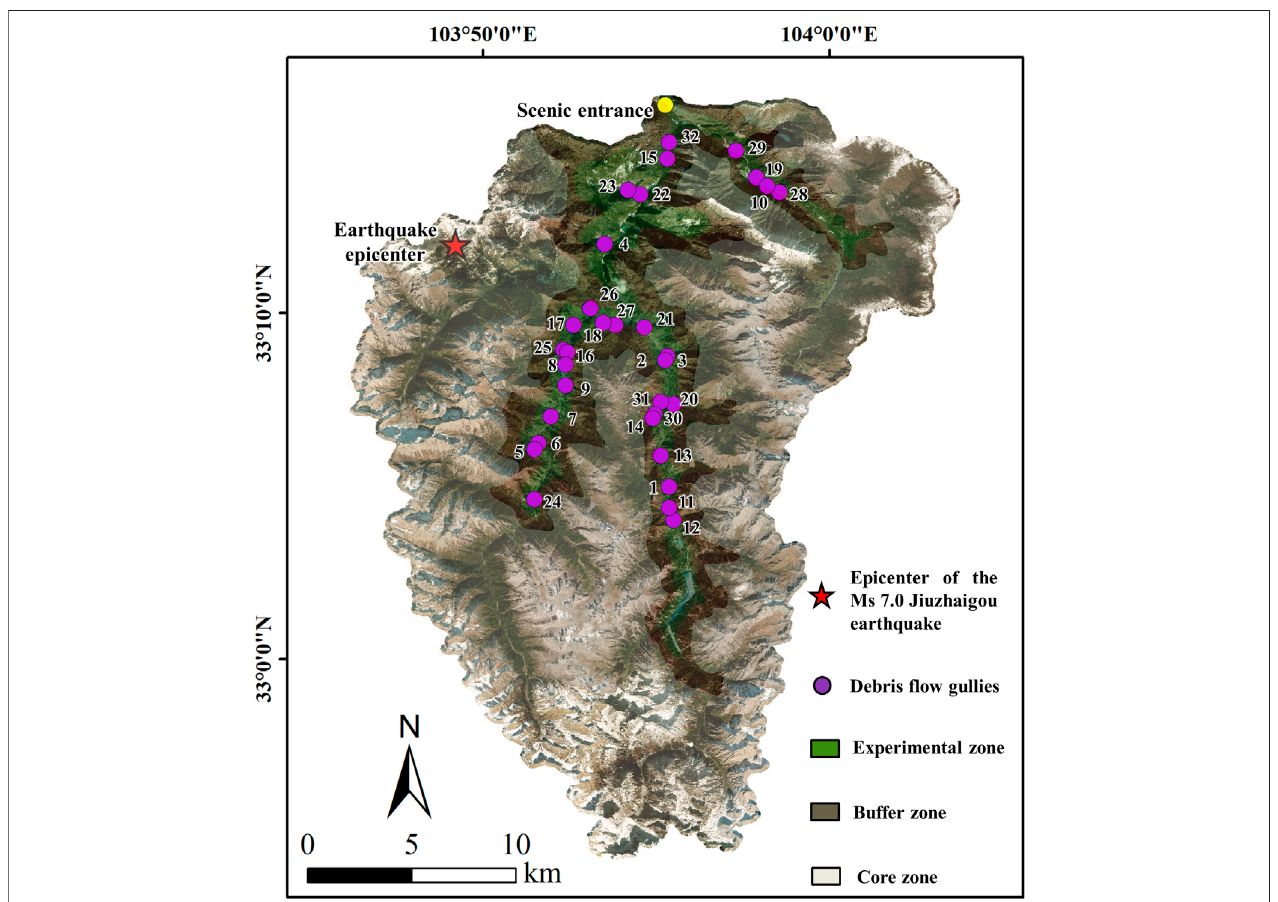
FIGURE 10 | Functional zoning map of Jiuzhaigou